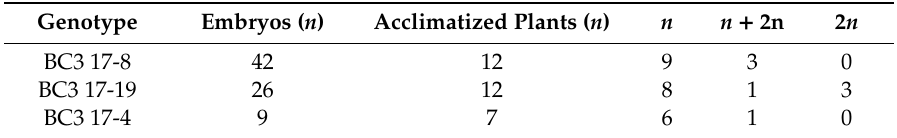
Table 4. Total embryos obtained in the three genotypes of the BC3 family 17 from the culture of anthers of the 5.5–6 mm range using the E6 protocol. The total number of acclimatized plants and their ploidy level analyzed by flow cytometry are